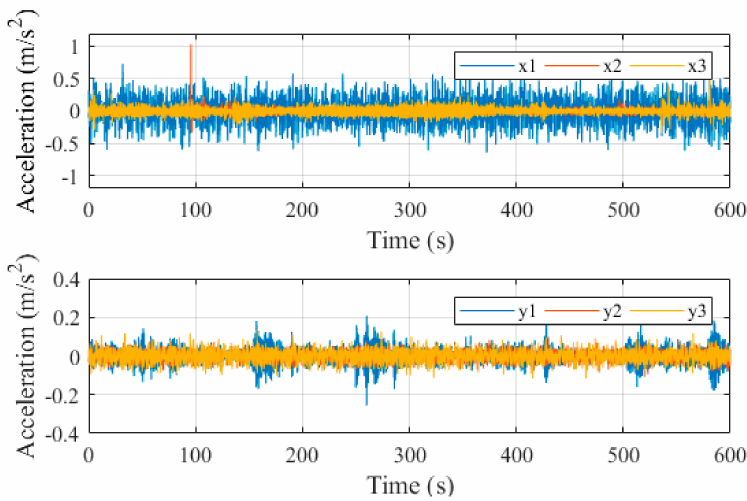
Figure 7. VAWT accelerations at 12 a.m. on 28 August